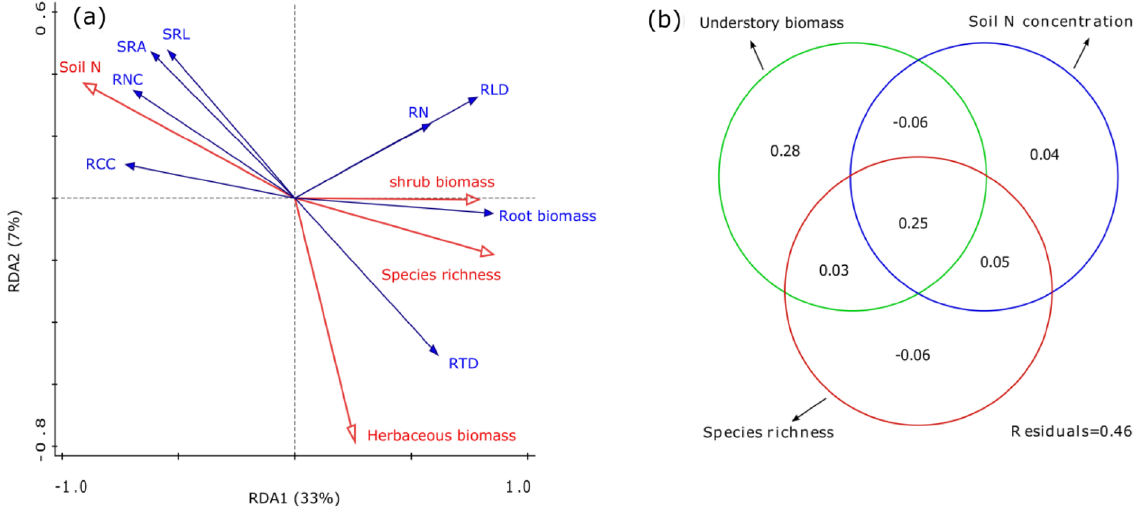
Figure 4. Bio-plot diagram of the redundancy analysis (RDA) for the absorptive root traits ( a ) and the Veen diagram ( b ) of relative contribution of environmental factors (soil condition, stand structure and composition) to variation of absorptive root traits. Lines with empty arrows show environmental factors (red lines), while lines with solid arrows indicate root traits (blue